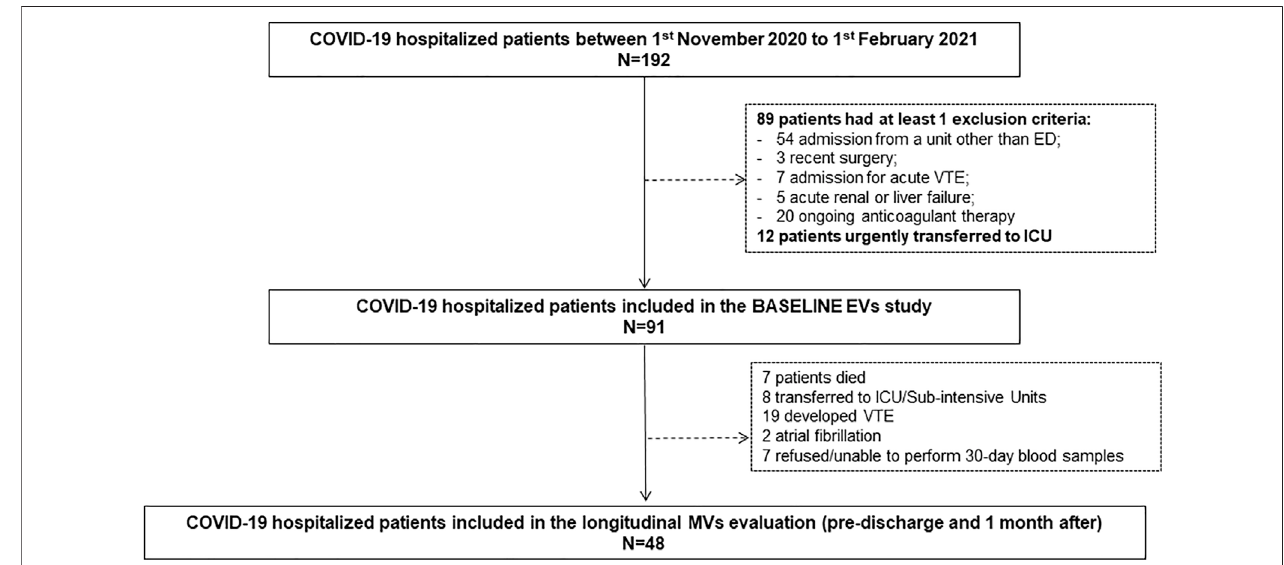
FIGURE 1 | Study fl